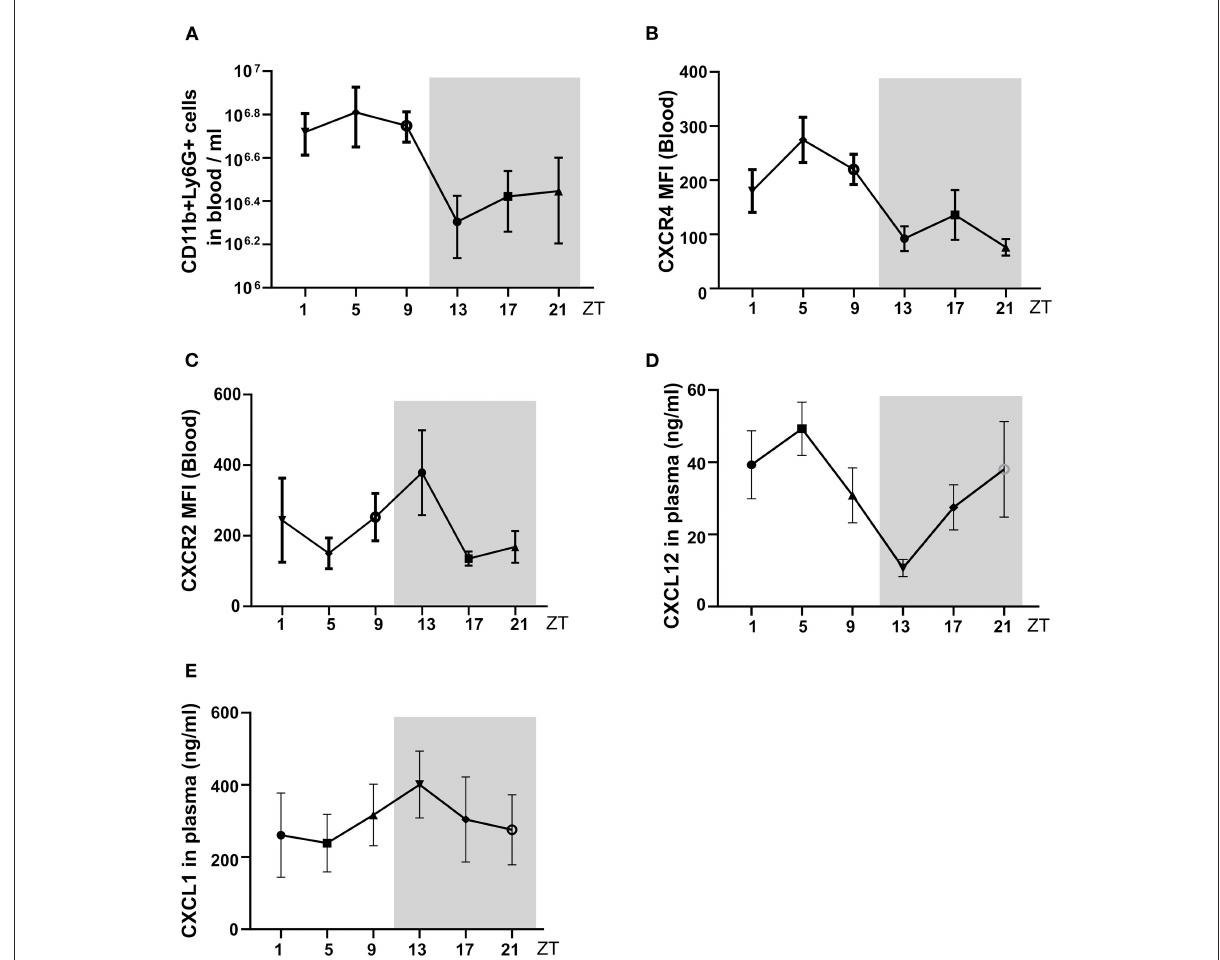
FIGURE2 The circadian oscillations of neutrophils, and chemokine in mouse blood in a healthy state. (A) Flow cytometric quantification of neutrophils baseline in the blood. (B,C) MFI of surface CXCR4 ( B , n = 5 mice/group) and CXCR2 ( C , n = 5 mice/group) expression by neutrophils in the blood as determined by flow cytometry. (D,E) Plasma levels of CXCL12 ( D , n = 5 mice/group) and CXCL1 ( E , n = 5 mice/group) in healthy mice as determined by ELISA. Data are means ± SD . MFI: mean fluorescence intensity; CXCR2, CXC chemokine receptor 2; CXCR4, CXC chemokine receptor 4; CXCL12, CXC motif chemokine ligand